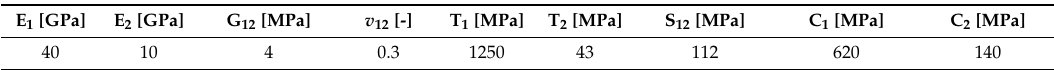
Table 2. Mechanical properties of the GFRP composite.